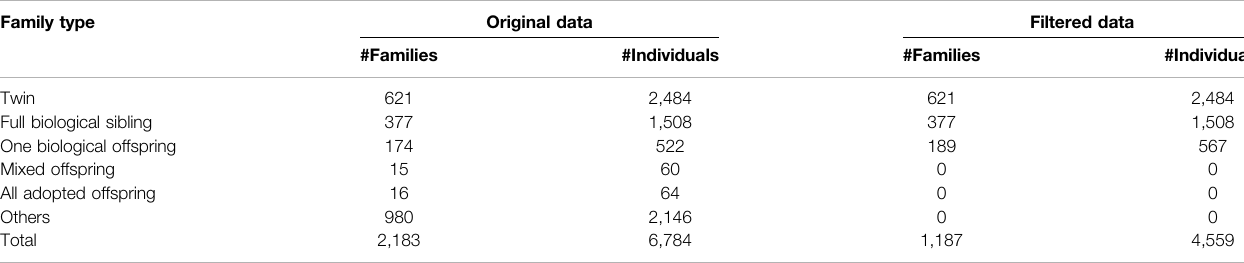
TABLE 1 | Samples fi ltered from original data.